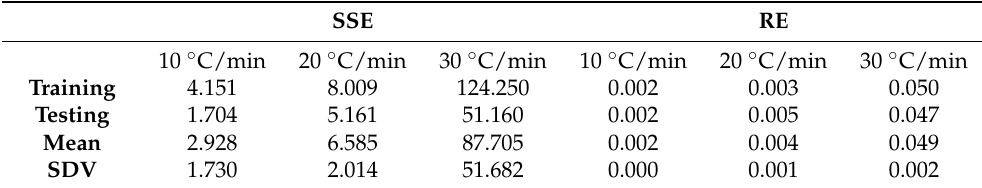
Table 6. Statistical parameters for the ANN model.